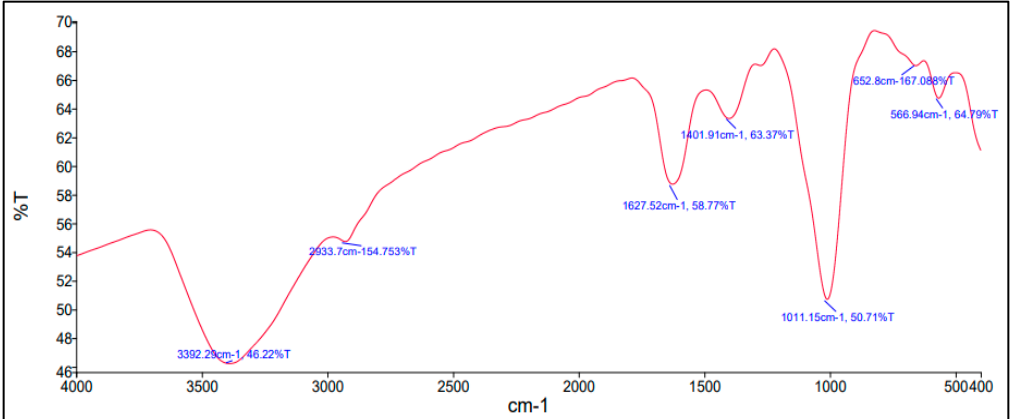
Figure 1. FTIR active allophane results.